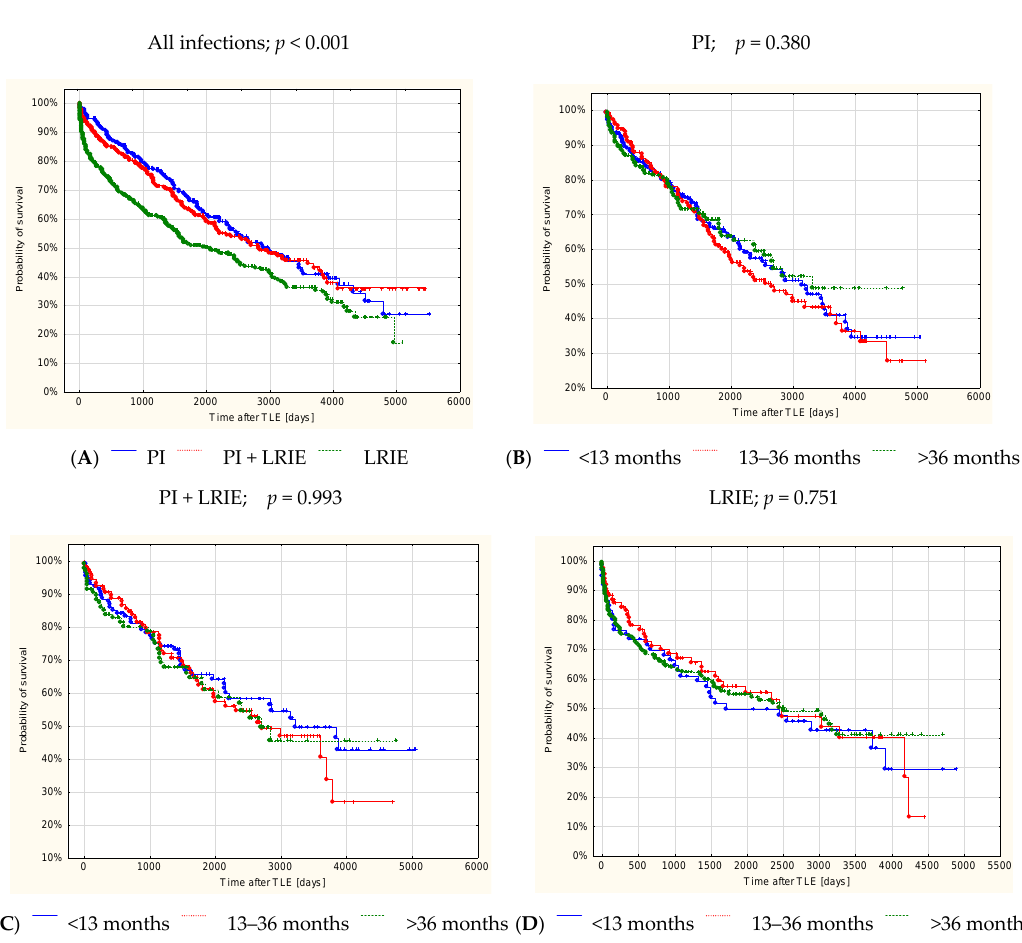
Figure 2. Probability of survival depending on onset of infection: ( A ) All cardiac implantable device infections. ( B ) Isolated pocket infections. ( C ) Pocket infection coexisting with systemic infections. ( D ) Lead-related infective endocarditis. ( A ): Probability of survival after TLE depending on infection type p < 0.001. ( B ): Probability of survival after TLE due to pocket infection depending on temporal onset related to last CIED procedure p = 0.680. ( C ): Probability of survival after TLE due to pocket and systemic infection depending on temporal onset related to last CIED procedure p = 0.993. ( D ): Probability of survival after TLE due to systemic infection depending on temporal onset related to last CIED procedure p = 0.751.